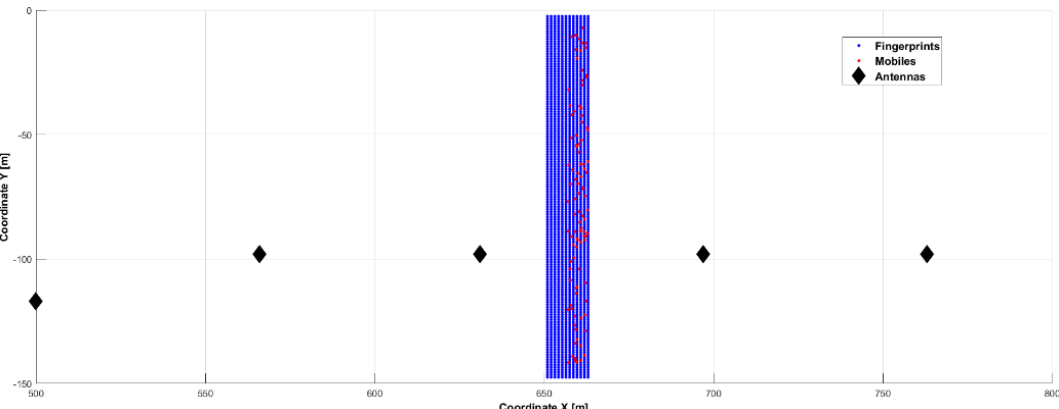
Figure 13. 2D view of Terminal 4 at Adolfo-Suarez Madrid-Barajas International Airport simulation area: A section of 12 × 145 m containing 1740 fingerprints, 99 mobiles to locate and 5 APs.